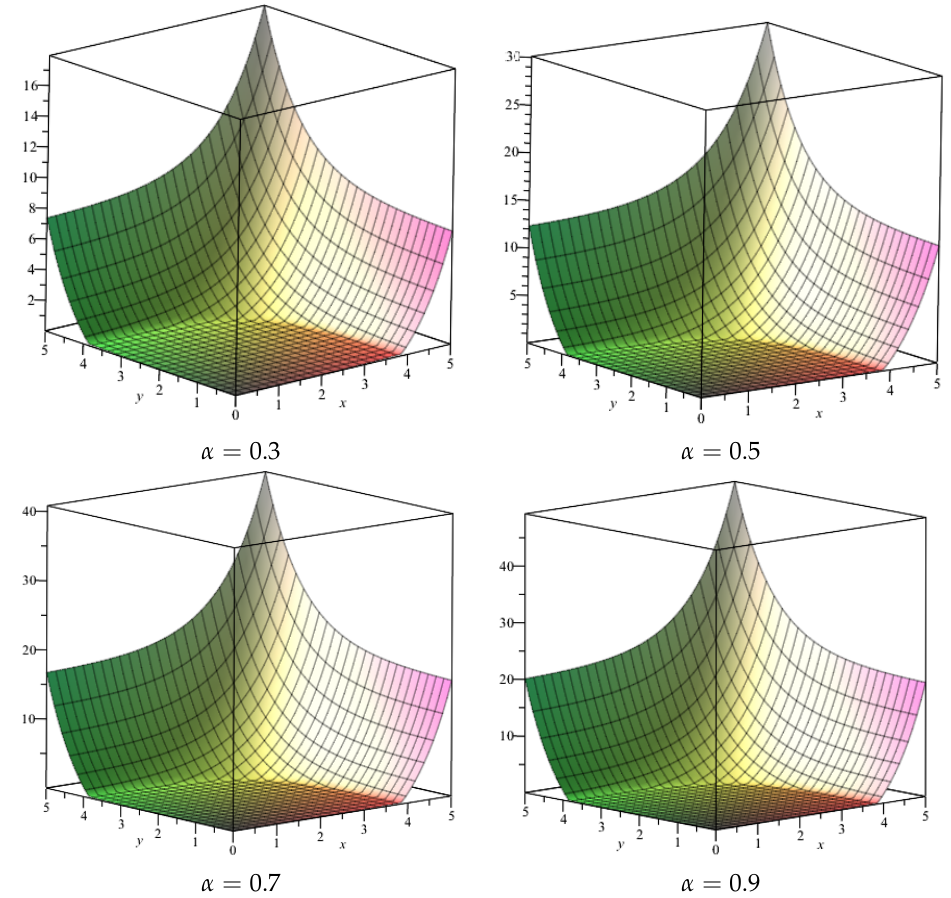
Figure 3. The graphs of the option pricing with different fractional-order α